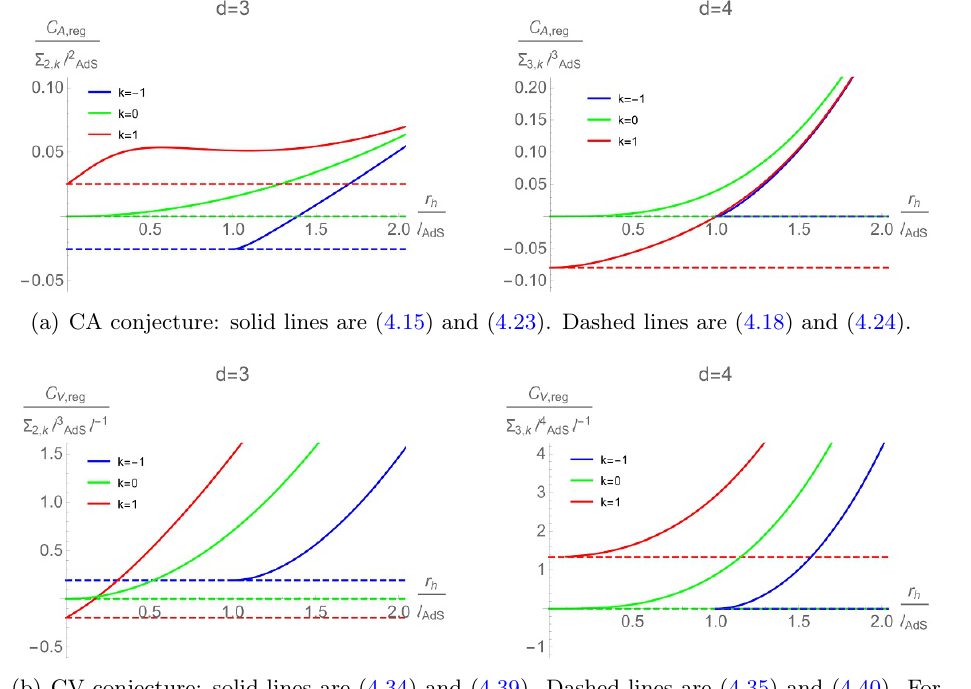
Figure 6 . Regularized complexity. The regularized complexity may be negative but the complexity of formation (solid line minus dashed line) is always positive, which agree to (cid:12)gure 4, 5, 10 and 11 in